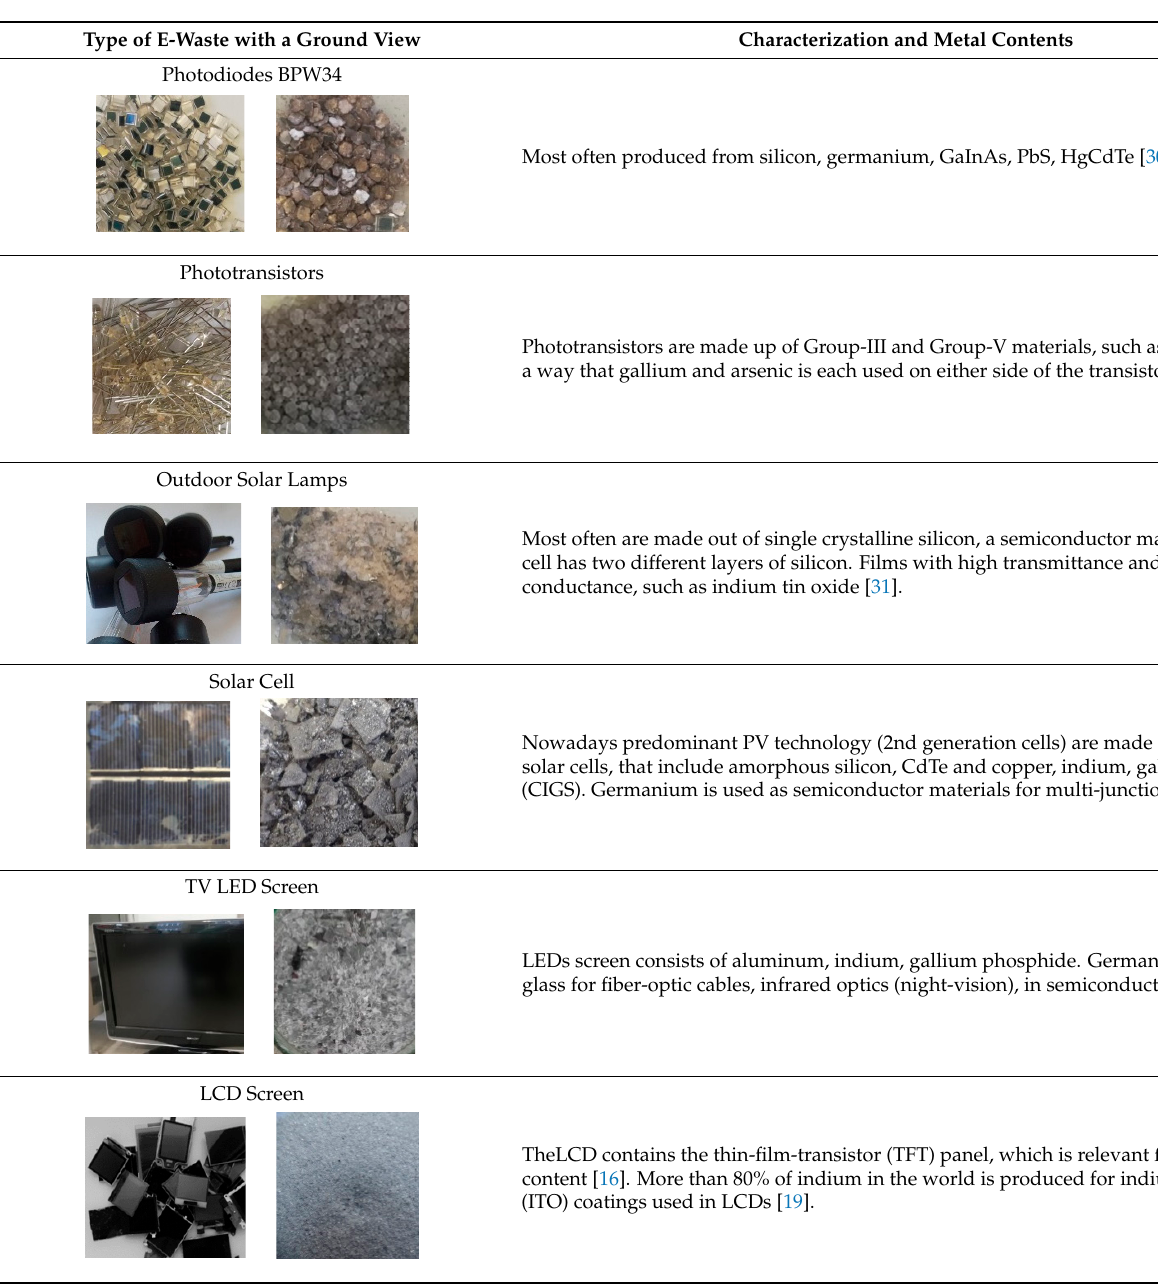
Table 3. The distribution of individual grain fractions in the ground